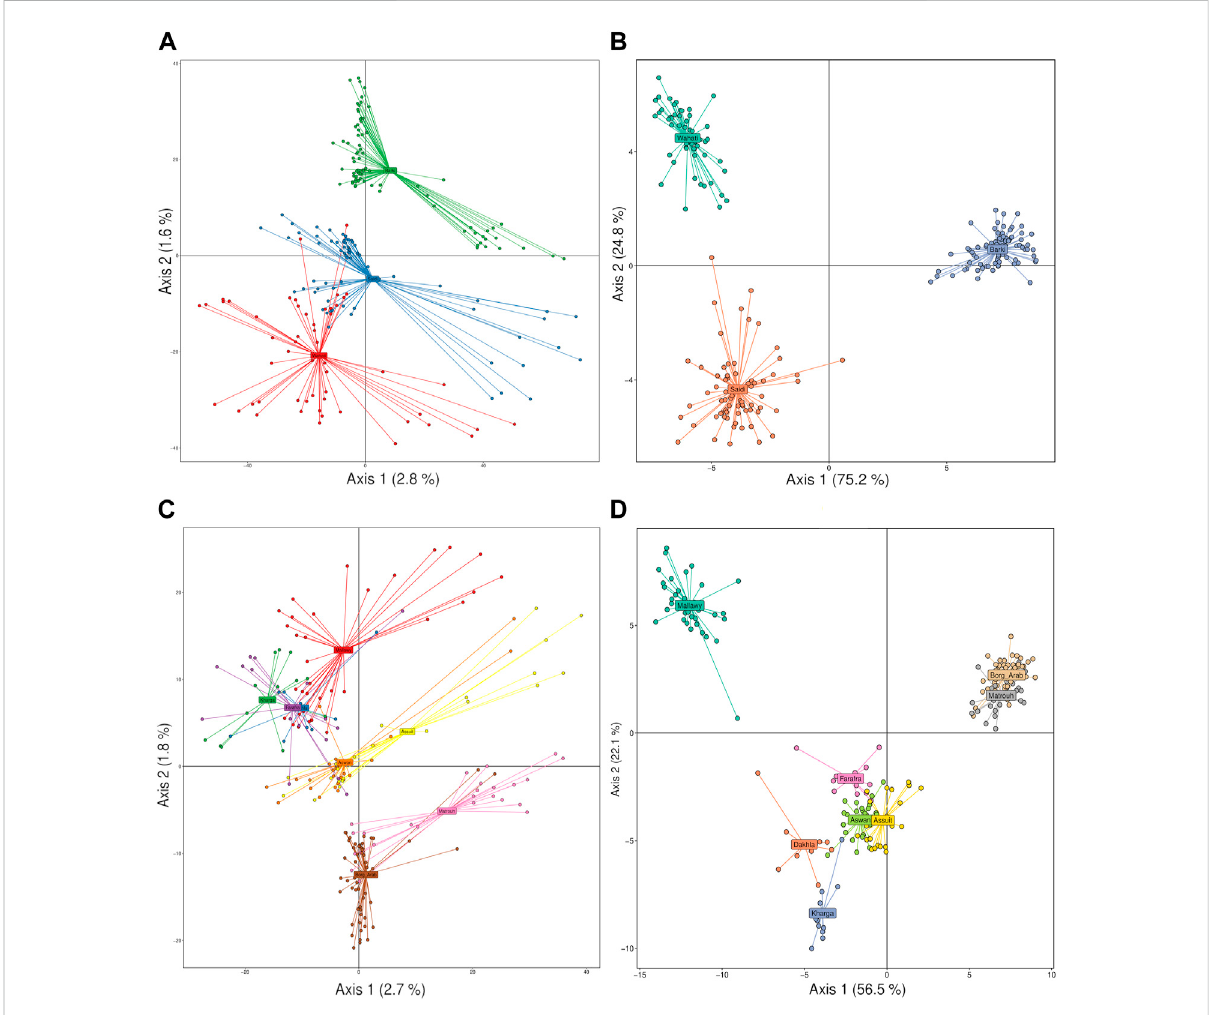
FIGURE 3 Discriminant analysis ofprincipalcomponents (DAPC) and PCA of theEgyptian sheep breed studied performed based on SNP genotyping data. Breed data was clustered using DAPC (A) and PCA (B) , and geographical location data was clustered using PCA (C) and DAPC (D)